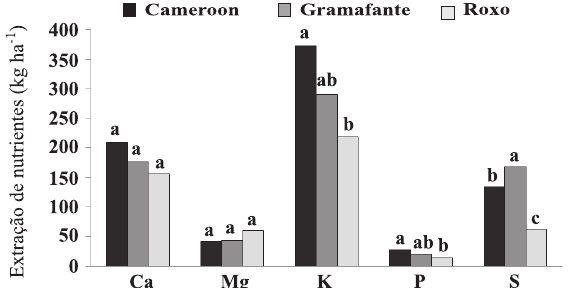
figura 3. Extração de cálcio, magnésio, potássio, fósforo e enxofre por três variedades de capim-elefante. letras minúsculas comparam as variedades para cada nutriente. letras minúsculas iguais não diferem (tukey, p ≤ 0,05).